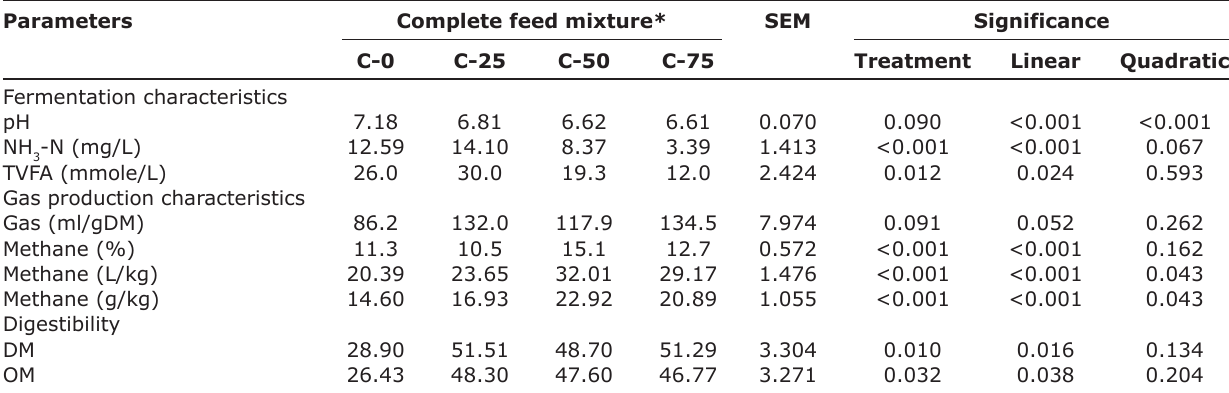
Table-3: In-vitro fermentation characteristics of gram straw based substrate with varying R:C (mean of three observations).